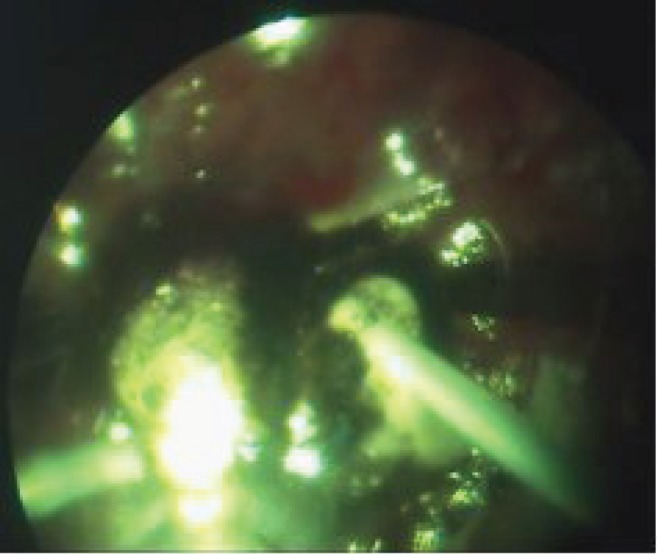
The ECL procedure.